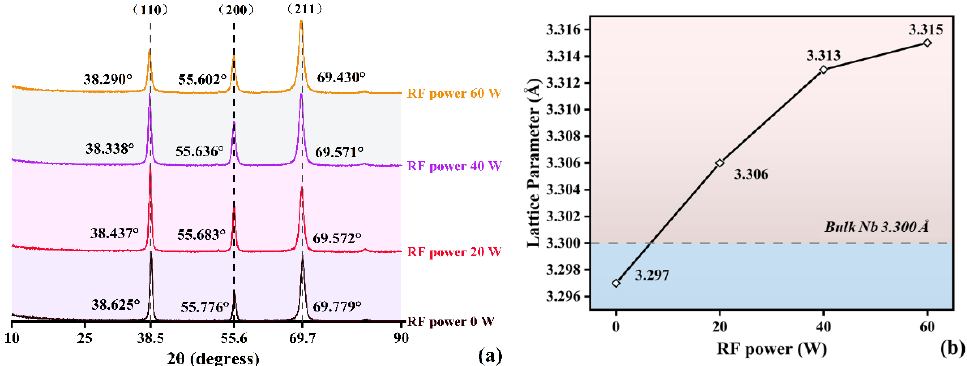
Figure 7. ( a ) Diffraction angle offset and ( b ) lattice parameters of the Nb films deposited under RF bias powers.